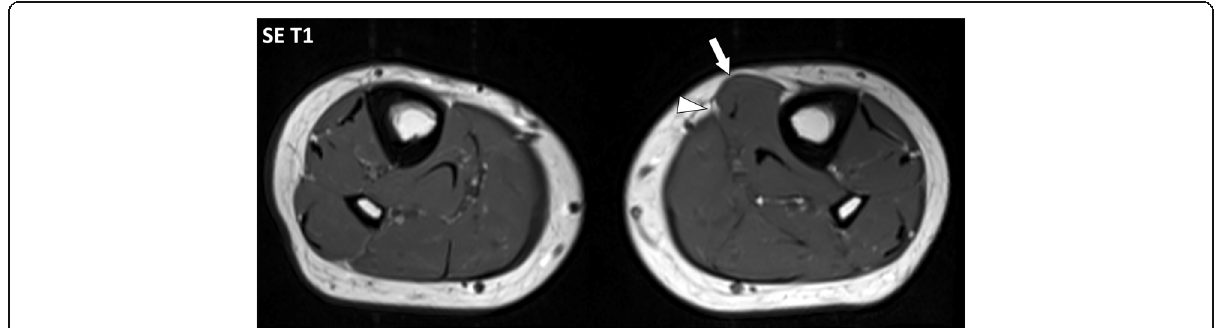
Fig. 6 Axial SE T1w image of the legs of a 23-year-old male with muscle hernia after open fracture and surgery of the left leg. Deep peripheral fascia of the antero-medial part of the left leg is interrupted (arrowhead) with herniation of the flexor digitorum longus muscle in the hypodermic fat